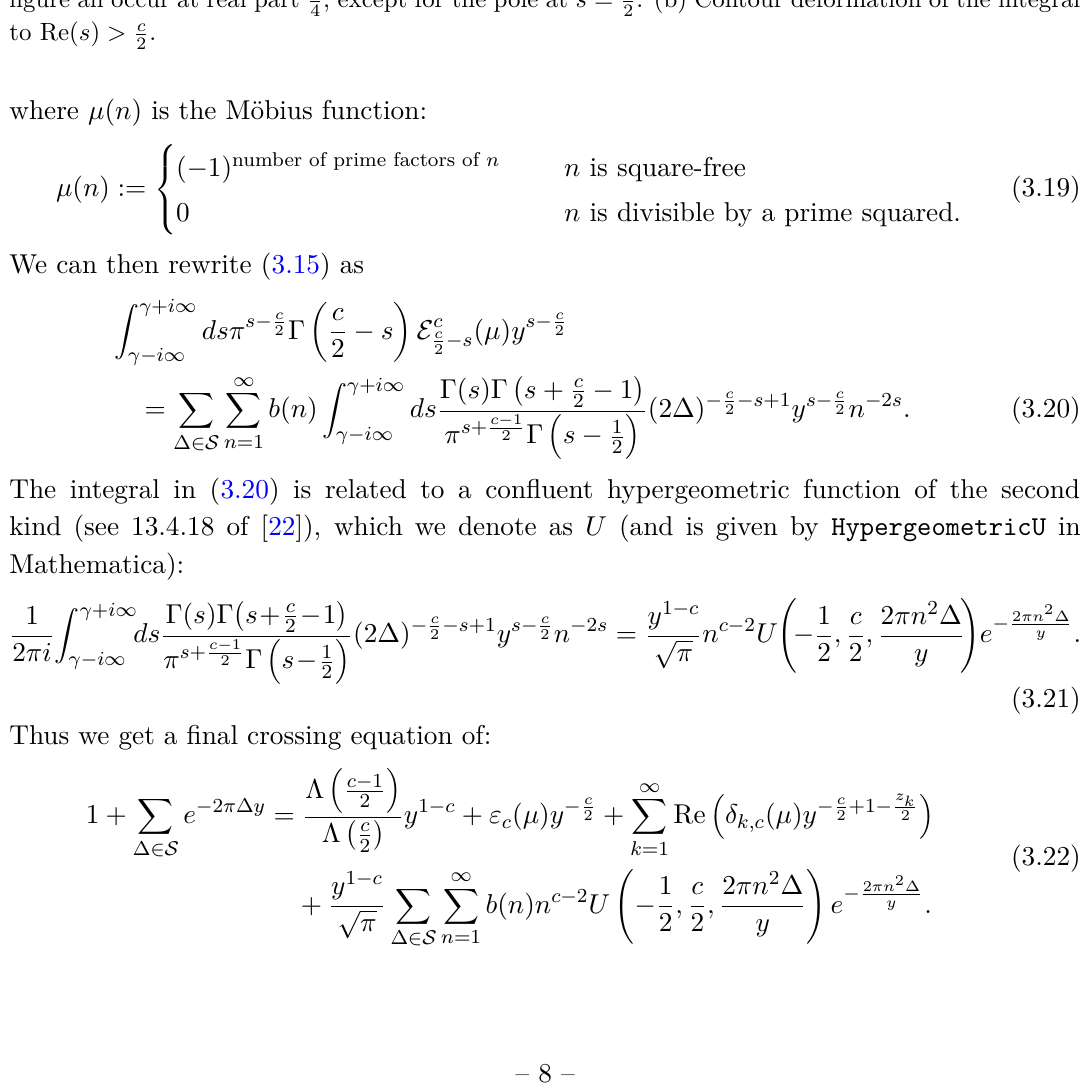
(b) are the nontrivial zeros of the Riemann zeta n . (b) Contour deformation of the integral 2